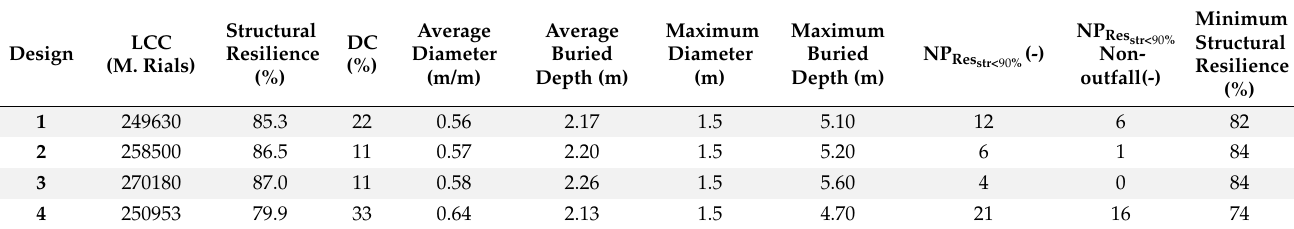
Table 4. Hydraulic and layout specifications of different